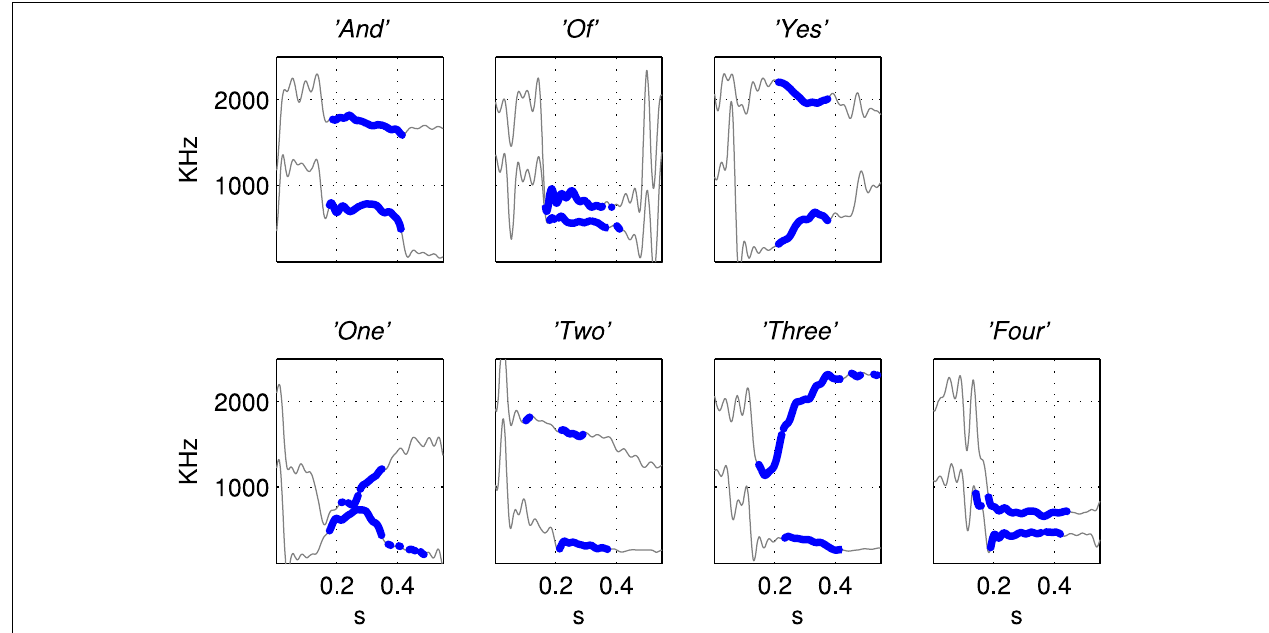
FIGURE 3 | Illustration of the derivation of simplified stimuli consisting of the first and second formant tracks for the seven words extracted using Linear Predictive Coding. The words were “And”, “Of”, “Yes”, “One”, “Two”, “Three”, “Four” as labeled in titles of subfigures. The thin line segments (in